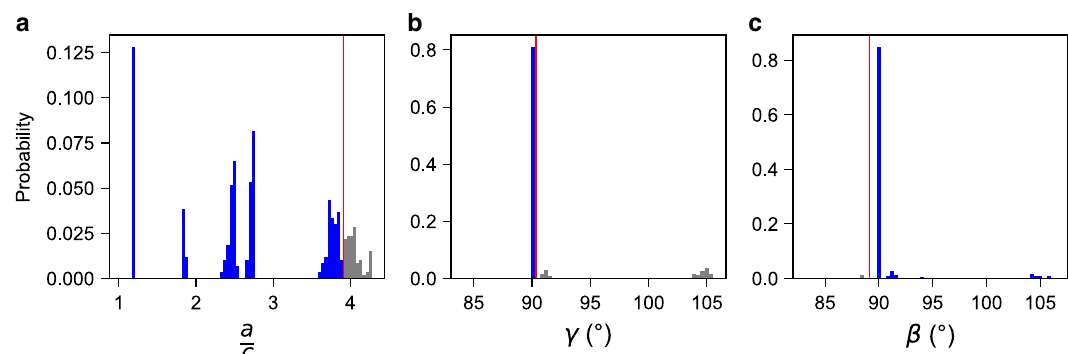
Fig. 4 Effect of individual DA selector conditions for SOAP-based model. The distributions of the three features referenced in the selector σ SOAP ≡ a / c ≤ 3.87 ∧ γ < 90.35 ∘ ∧ β ≥ 88.68 ∘ , i.e., a / c ( a ), γ ( b ), and β ( c ), are shown with subpopulation selected by condition in blue, subpopulation deselected in gray, and threshold by